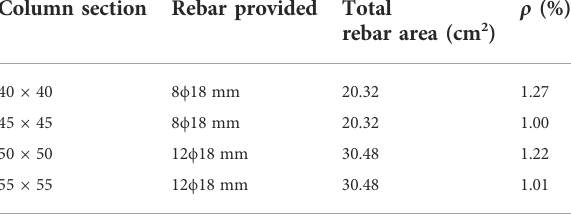
TABLE 7 Longitudinal reinforcement for columns. Column section Rebar provided Total